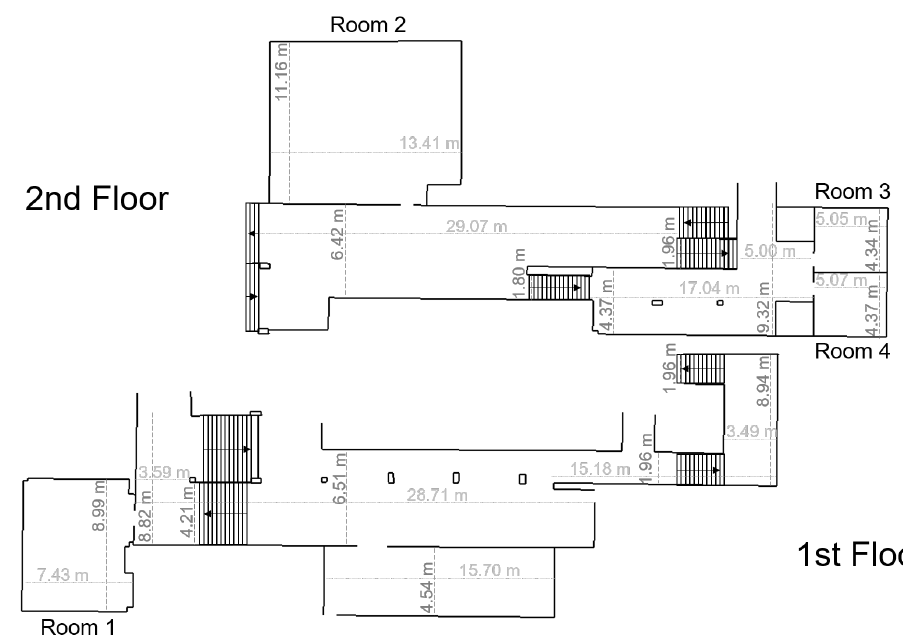
Figure 4. The floorplan of the study site with the dimensions of the rooms and